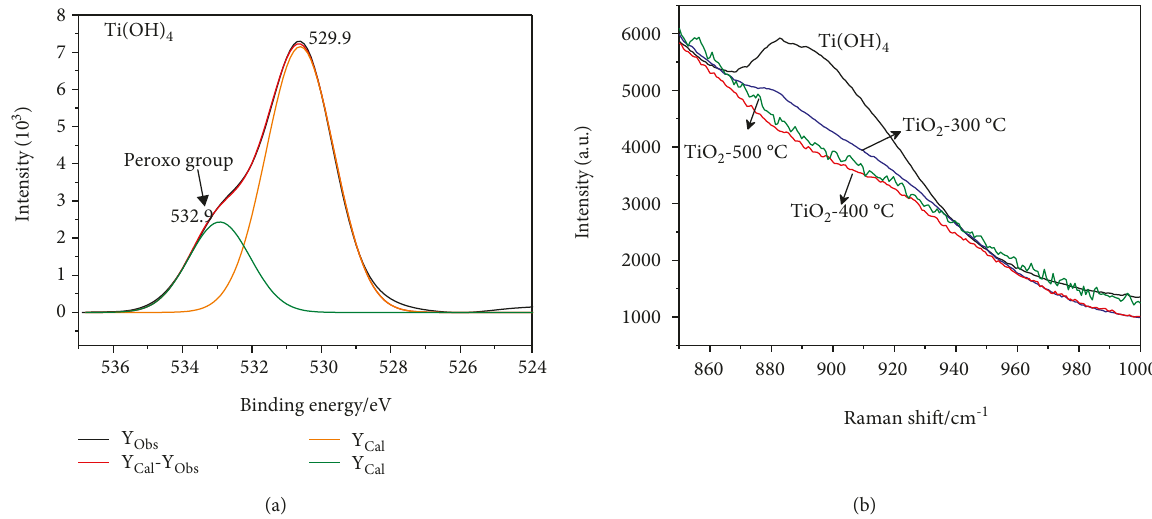
Figure 1: (a) XPS pro fi le of Ti(OH)